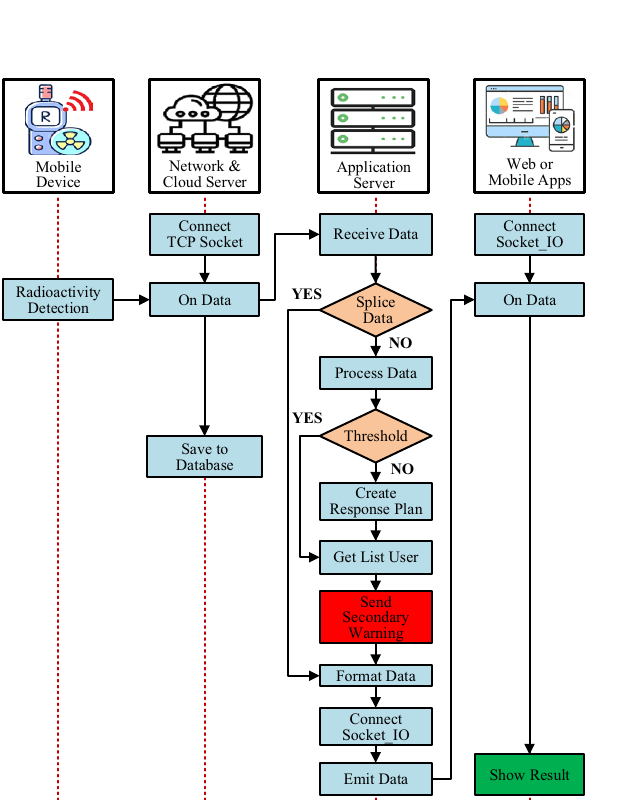
Figure 10. Flowchart of radiation confirmation and secondary warning activation on the mobile